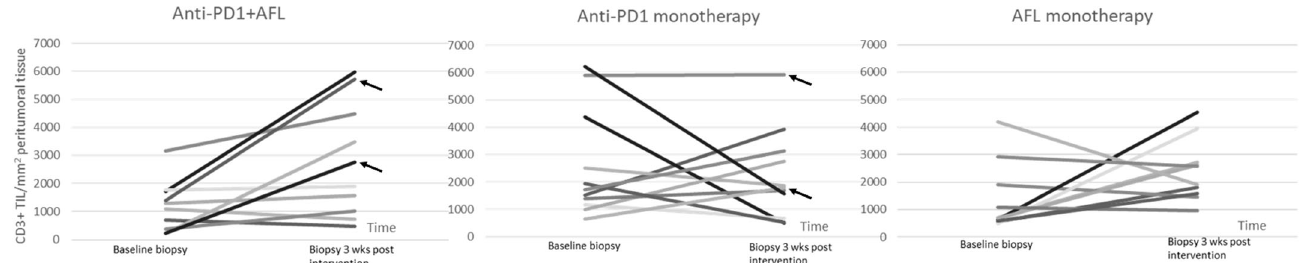
Figure 1. CD3+ T ‐ cells in the three intervention groups before and after intervention. Each line rep ‐